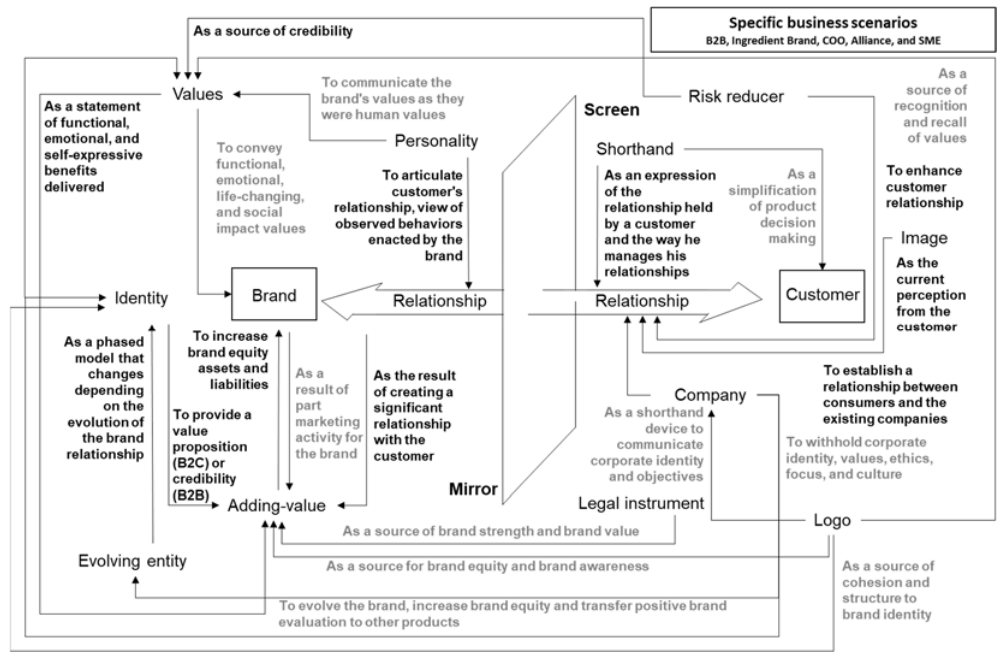
Figure 5. Guidelines for a custom brand management strategy for the B2B, ingredient brand, COO, alliance, and SME scenario.